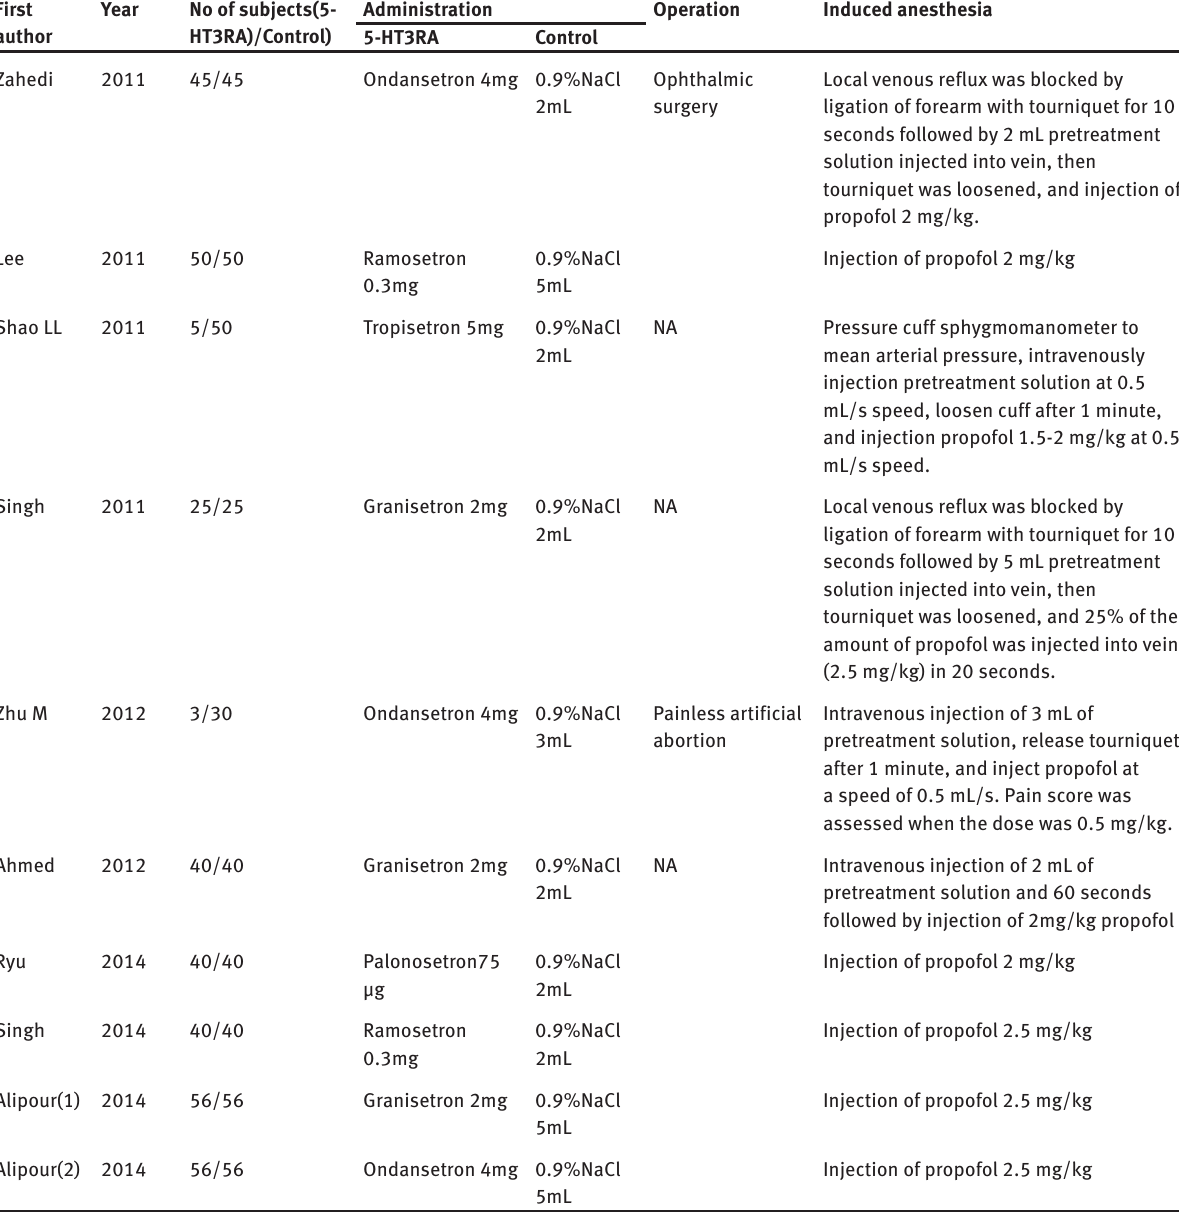
5-HT receptor antagonists ondansetron, granisetron, 3 tropisetron, palonosetron, and ramosetron, the